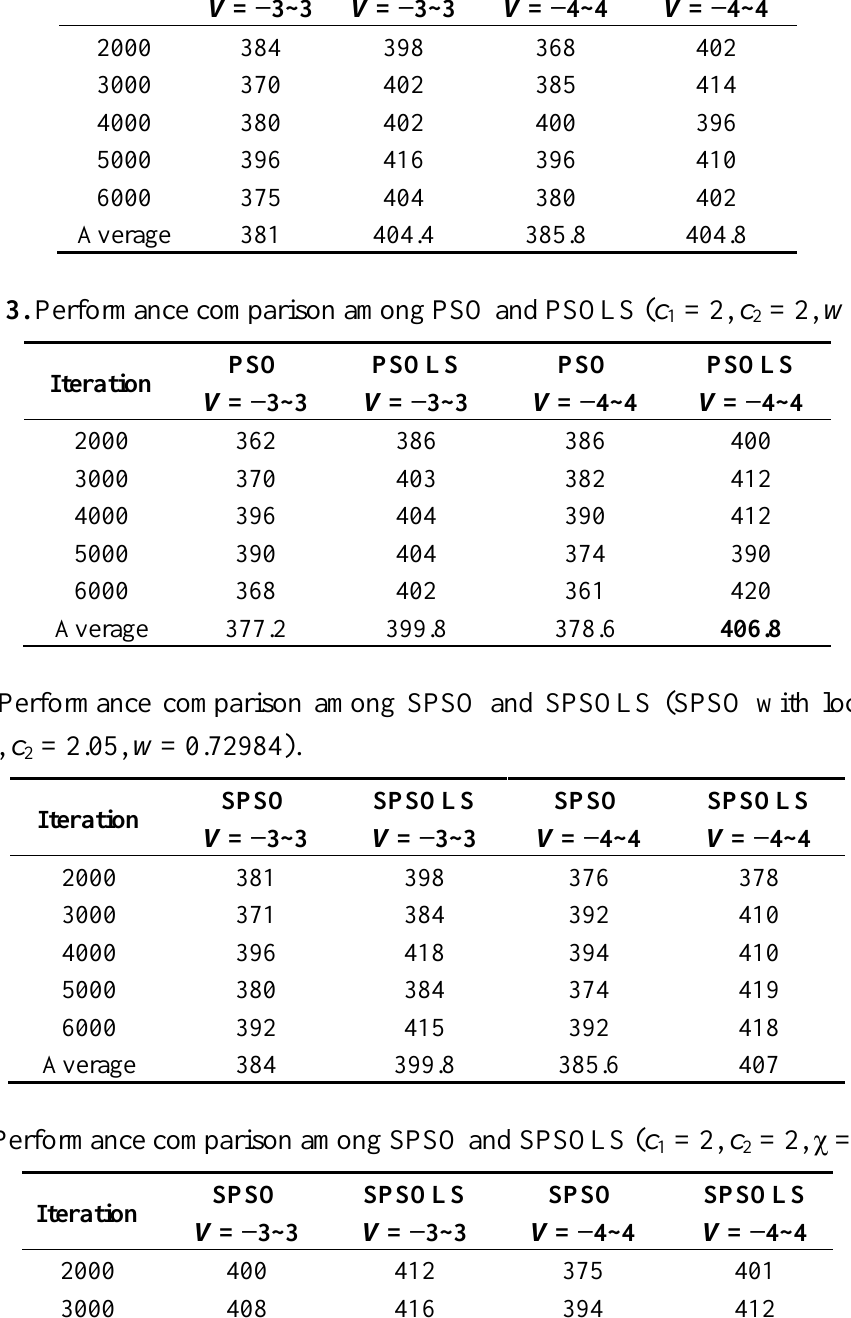
Table 2. Performance comparison among PSO and PSOLS (PSO with local search) ( c = 2.05, c = 2.05, w = 0.8). 1 2